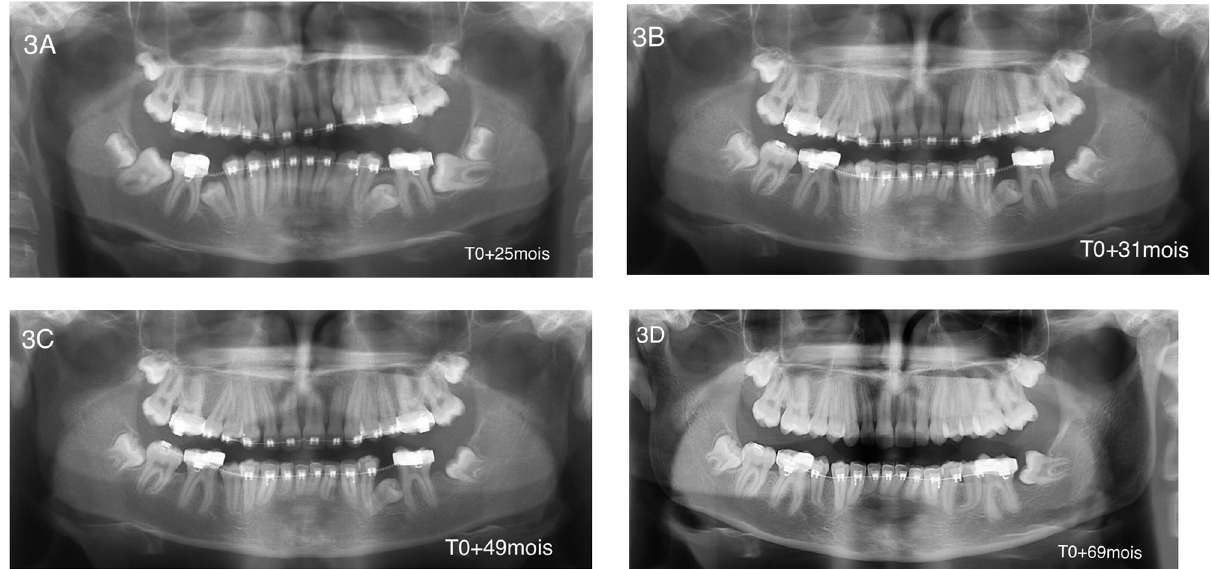
Fig. 3. Patient B; 4 years after radiological follow-up. (A) First panoramic X-ray (T0+25 months). The start of orthodontic treatment with delayed eruption of teeth 35, 45, and 37 tilted on the mesial side. Four wisdom teeth were unerupted. (B) Panoramic X-ray after 6 months of follow-up (T0+31 months). Tooth 37 was extracted. (C) Panoramic X-ray after 2 years of follow-up (T0+49 months). Tooth 45 was in a normal position, and tooth 35 was still unerupted. (D) Panoramic X-ray after approximately 3.5 years of follow-up (T0+ 69 months). Tooth 35 was in a normal position, and tooth 38 was surgically exposed for orthodontic procedures. Teeth 45 and 35 show a radicular hook apical